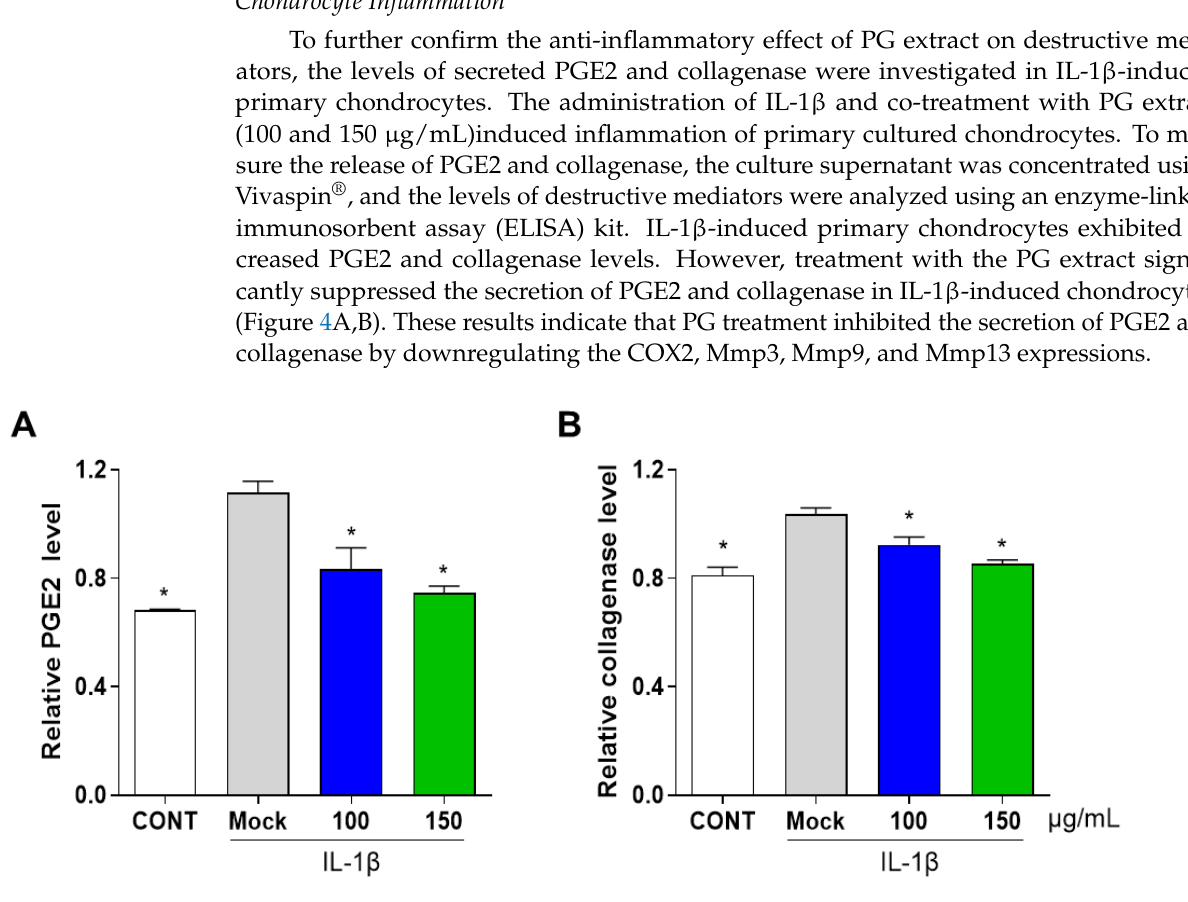
Figure 4. Effect of PG extract on destructive mediators in IL-1 β induced primary chondrocyte inflammation. Primary cultured mouse chondrocytes were incubated with different concentrations of PG extract (100 and 150 µ g/mL) in the presence of IL-1 β . ( A ) PGE2 and ( B ) collagenase levels in the cell supernatants were examined. * p < 0.05 vs. Mock. CONT; non-treated